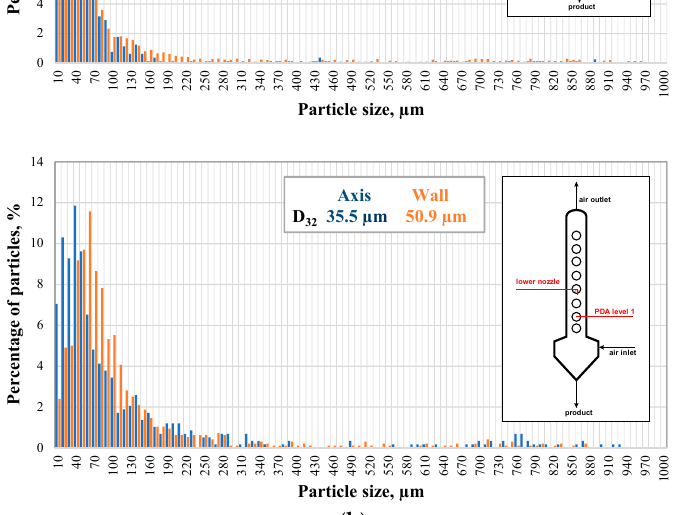
( b ) Figure 7. Product photos from the stereoscopic microscope for the nozzle at the top position ( a ) and bottom position ( b ) (adapted from Ref. [33]).